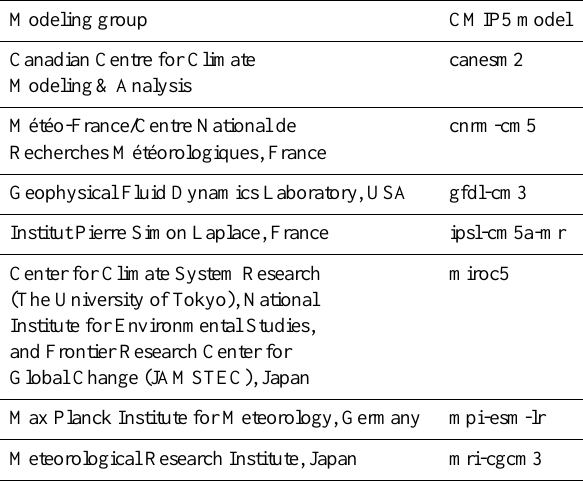
Table 2. Summary of streamflow calibration statistics. Calibration